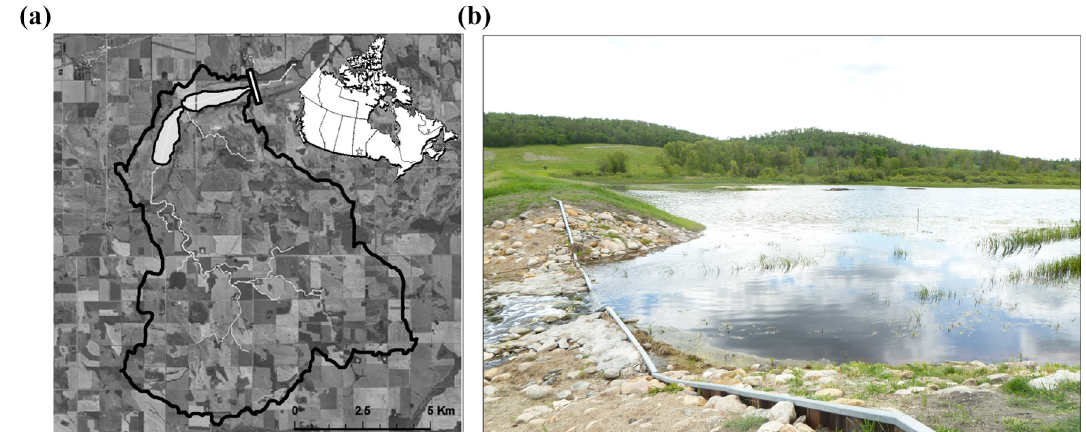
Fig. 1 Pelly’s Lake, Manitoba a Pelly’s Lake situated within the watershed boundary. Dike location is illustrated by the rectangle located at the northeast end of the lake b Concrete dike installation at Pelly’s Lake on the left with a view of the lake to the west of